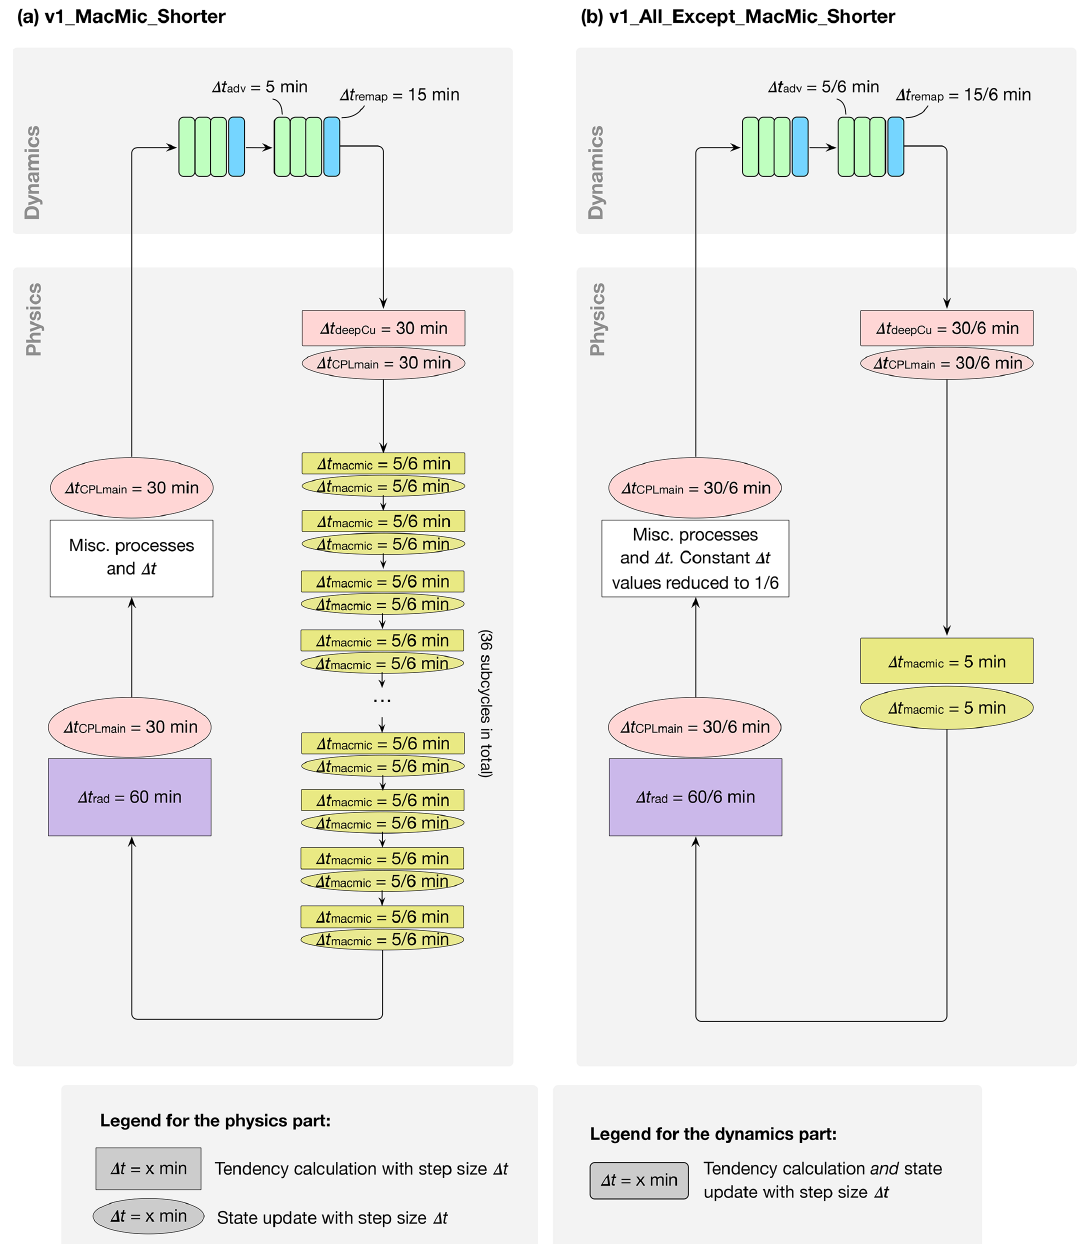
Figure 7. (a) Simulation v1_MacMic_Shorter wherein the time steps of the collectively subcycled stratiform cloud macrophysics and micro- physics are shortened to 1 / 6 of the default value, i.e., (cid:49)t macmic = 5 / 6min instead of 5min. (b) Simulation v1_All_Except_Macmic_Shorter wherein (cid:49)t macmic is kept at its default of 5min, while step sizes for the other parts of EAMv1 were shortened to 1 / 6. The color coding follows Fig. 1a. The simulation setups are summarized in Tables 1 and A1. The results are discussed in Sect.